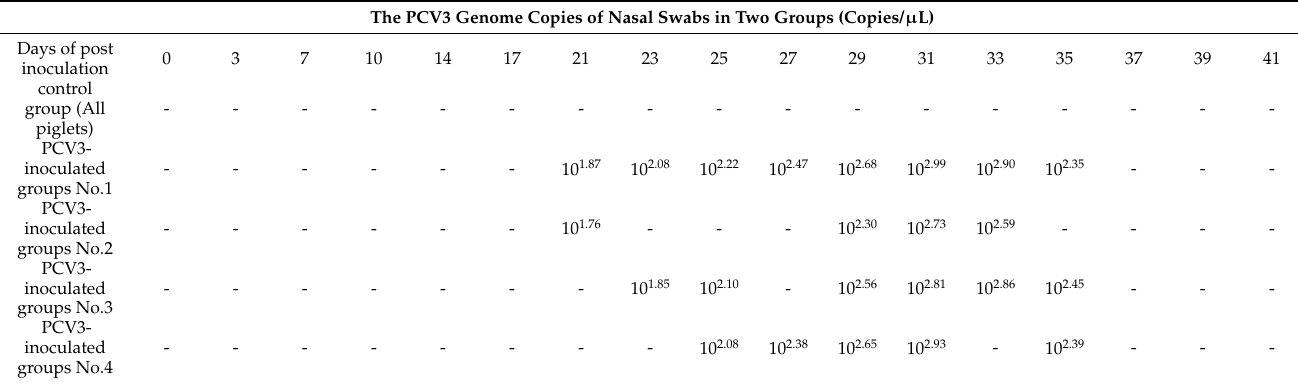
Table 2. Results of PCV3 detection by qRT-PCR in nasal swabs by individual pigs. The PCV3 Genome Copies of Nasal Swabs in Two Groups (Copies/ µ L)